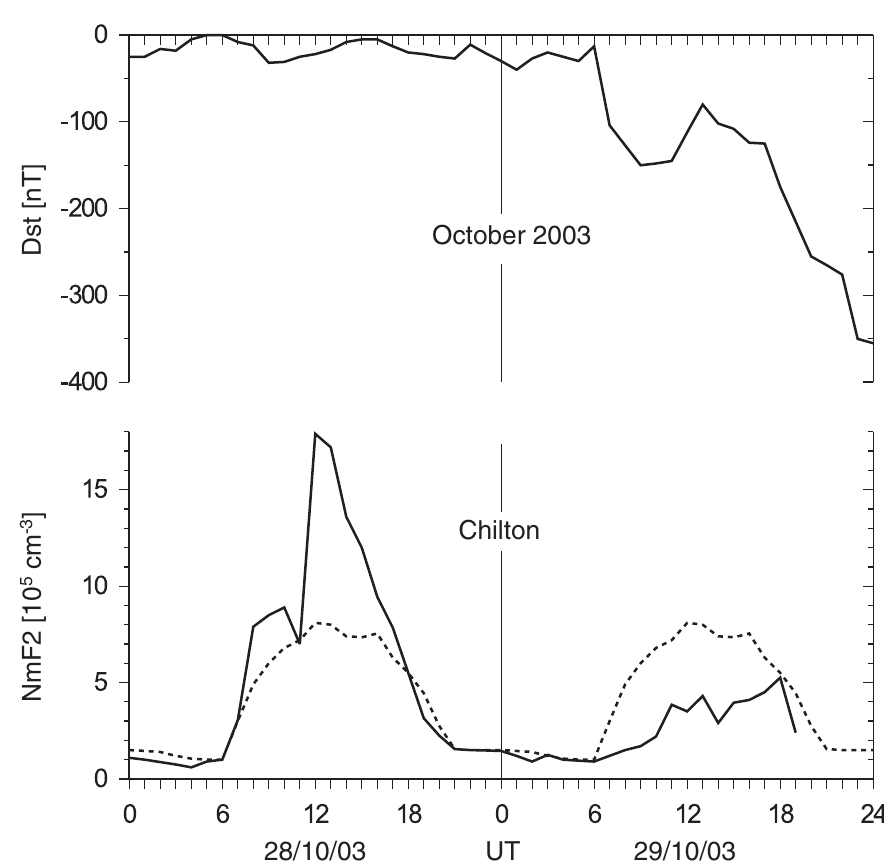
Fig. 13. Effects of the late October 2003 geomagnetic super-storm on NmF 2 for Chilton, England. Top plot: hourly D st variation, October 28-30. Bottom plot: NmF 2 (hourly values) response; full line – measured values, dashed line – monthly median values. A large pre-storm enhancement occurs in the middle of the day before the